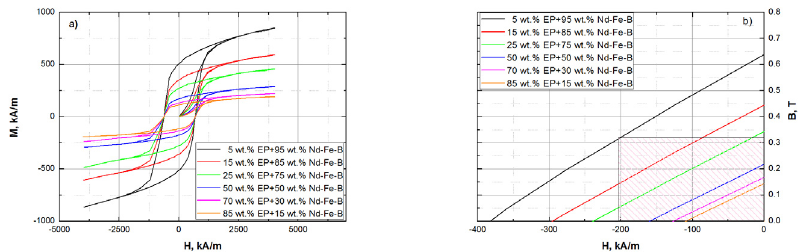
Figure 9. Hysteresis loops of magnetic composites in ( a ) M–H, and ( b ) B–H (second quadrant) dia- gram.